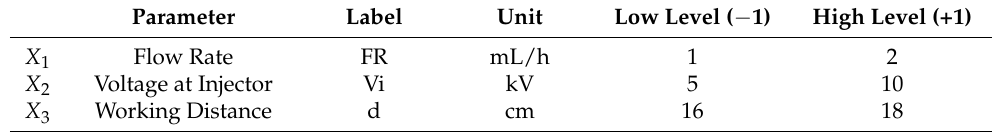
Table 1. Inputs ( X s )—selected processing parameters for the electrospinning of PSU solution 24% w/w . Parameter